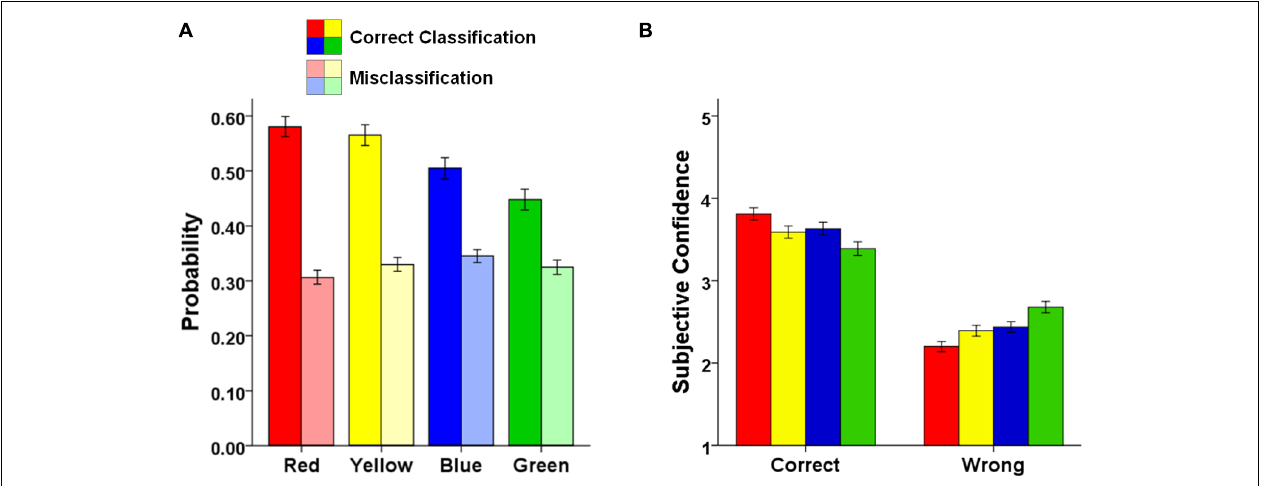
FIGURE 4 | Combined data set. Color effects on (A) the probability of correctly classifying an object’s color (saturated colors) and erroneously reporting a color in case of misclassification (pale colors), and (B) subjective confidence in correct and wrong color memories for the combined data set. Error bars represent SE of the